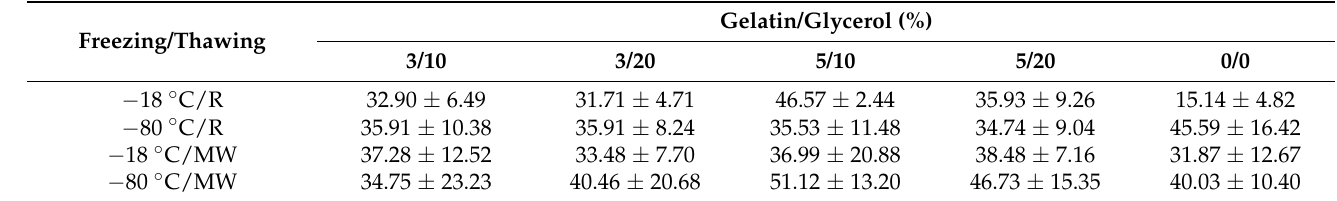
Table 5. Meat WBSF values ± SD [N] with and without coating depending on the method of freezing and